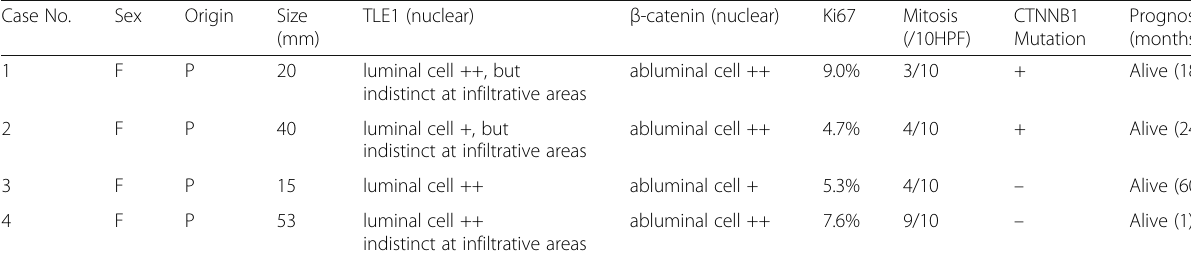
Table 2 Clinicopathological information of 4 basal cell adenocarcinoma cases Case No.